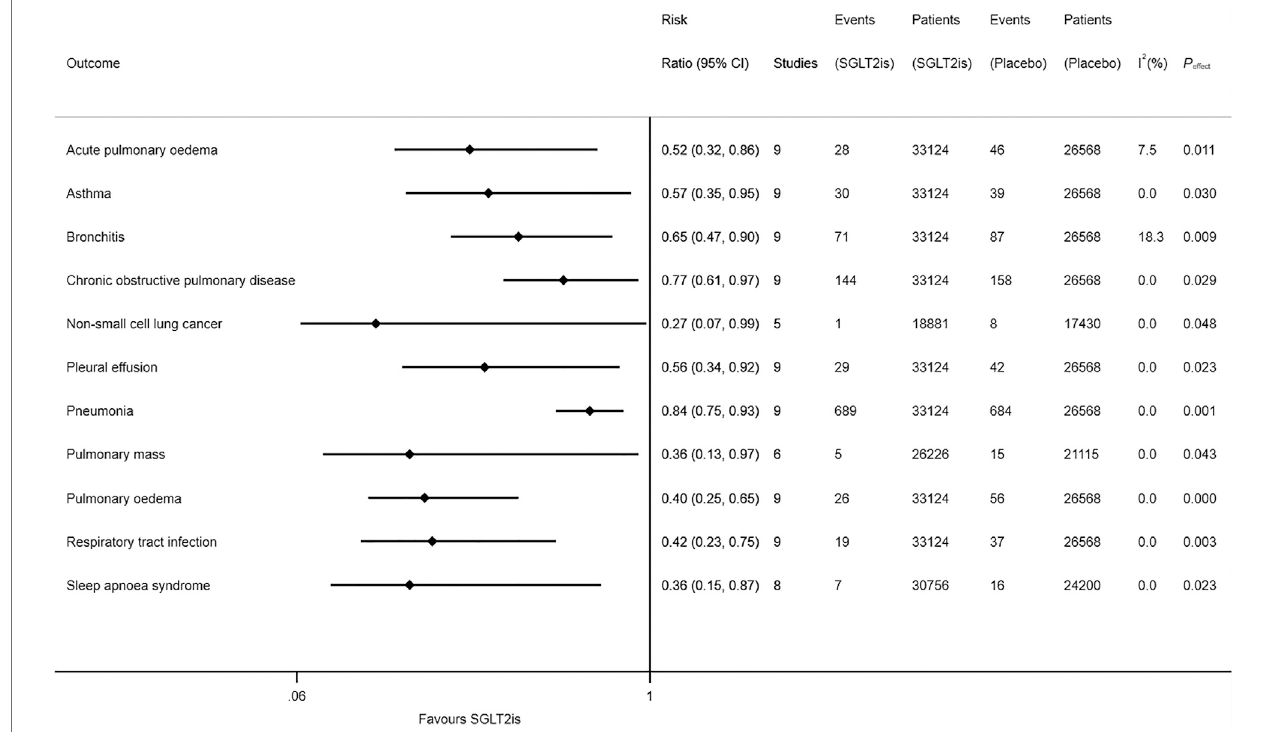
FIGURE 2 | Meta-analysis of SGLT2is and 11 types of respiratory